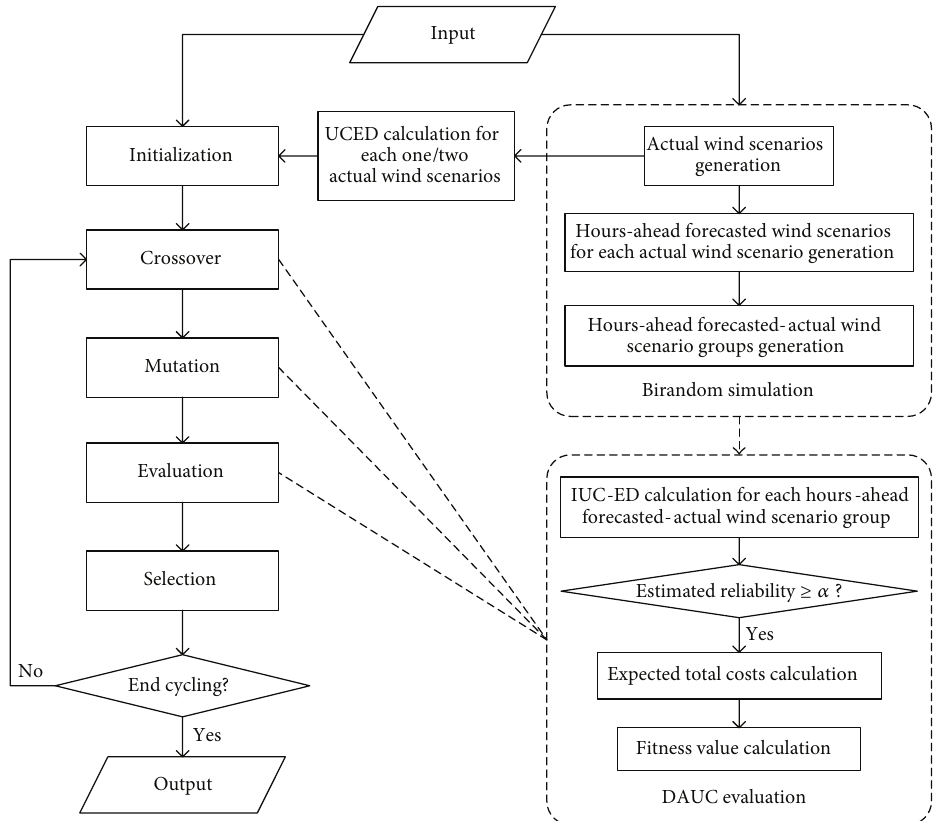
Figure 2: The flowchart of the birandom simulation-based GA